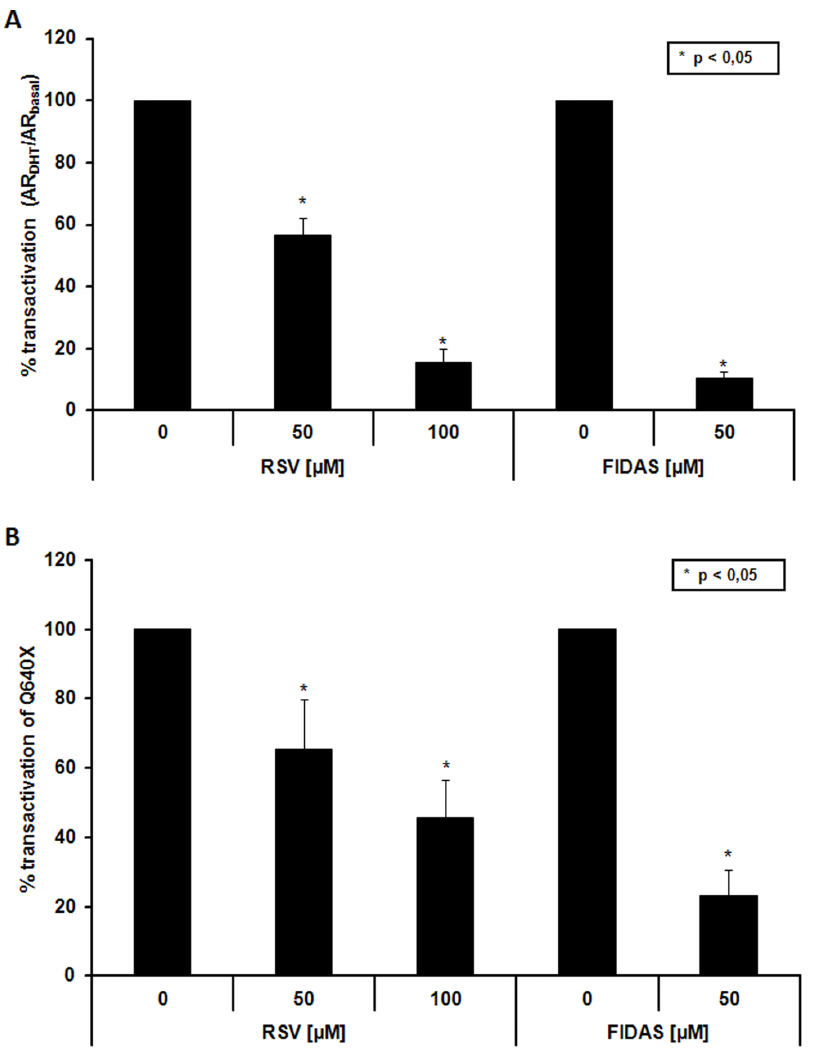
Figure 2. Effects of FIDAS and RSV on AR and Q640X signalling. PC-3 cells were transiently co-transfected with AR or Q640X, the pARE(2x)-luc reporter and the pRL-TK control plasmid as described in Material and Methods. ( A ) PC-3 cells transfected with AR were grown with/without 5 nM DHT in the presence/absence of RSV or FIDAS for 24 hours. Data are expressed as % transactivation of DHT stimulated AR (= % activity AR DHT /AR basal ) which was set at 100%; *p , 0.05. ( B ) PC-3 cells transfected with constitutively active Q640X were treated with RSV or FIDAS for 24 hours. Data are expressed as % transactivation of Q640X which was set at 100%, *p , 0.05).